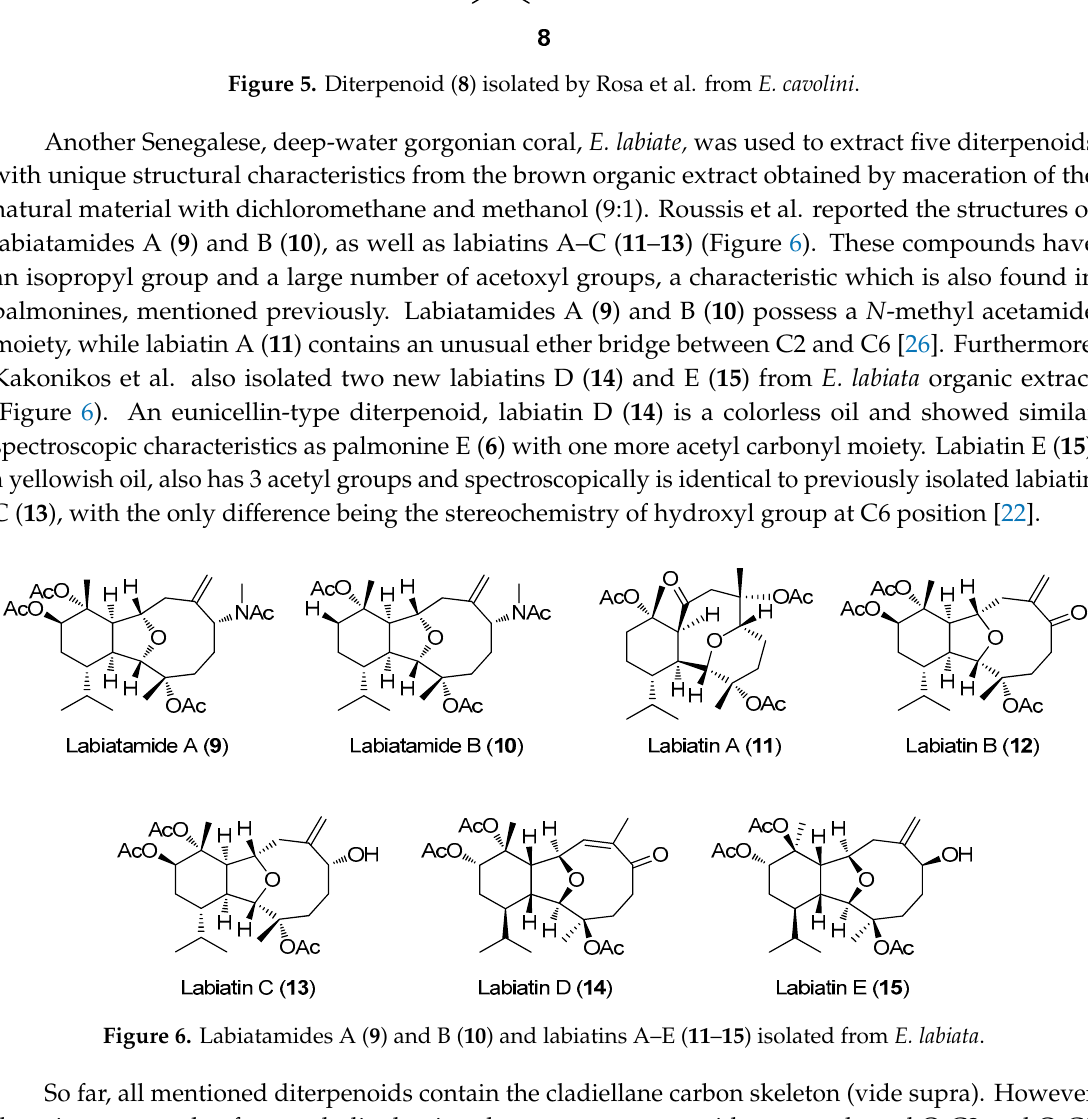
Figure 5. Diterpenoid ( 8 ) isolated by Rosa et al. from E. cavolini .